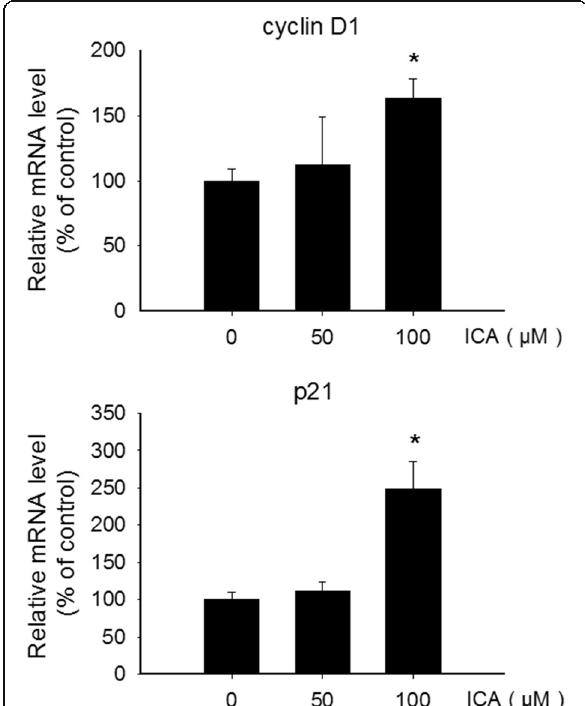
Fig. 5 Effect of ICA on the expression of cyclin D1 and p21 mRNA in NSCs. The expression of cyclin D1 and p21 mRNA was detected by qRT-PCR. Values represent mean ± SD of five individual experiments. * P < 0.01 vs Control